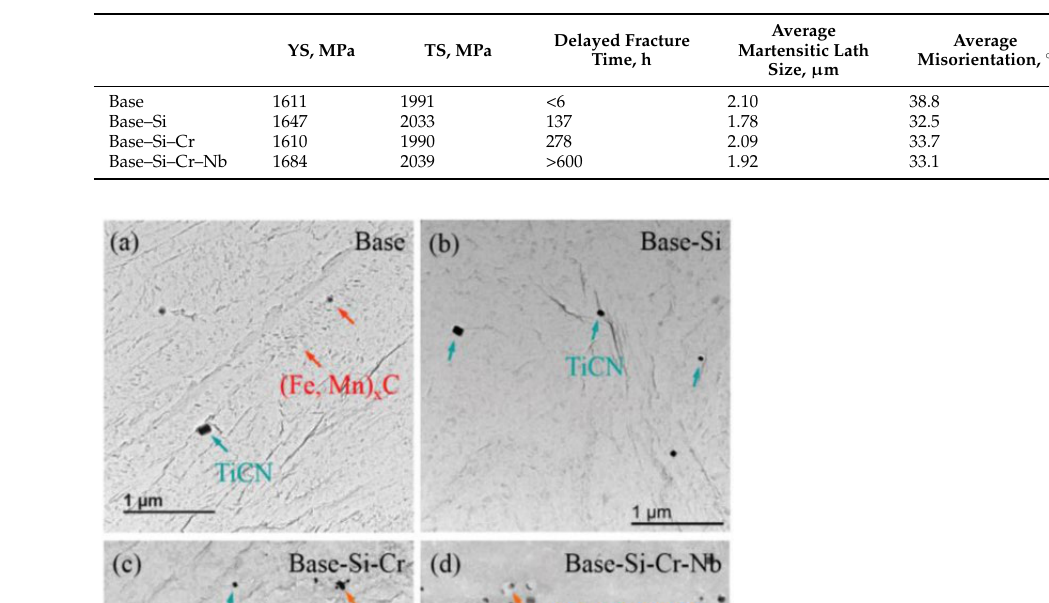
Table 2. Effect of alloying elements Si, Cr, and Nb on mechanical properties, delayed fracture, and microstructure [80].